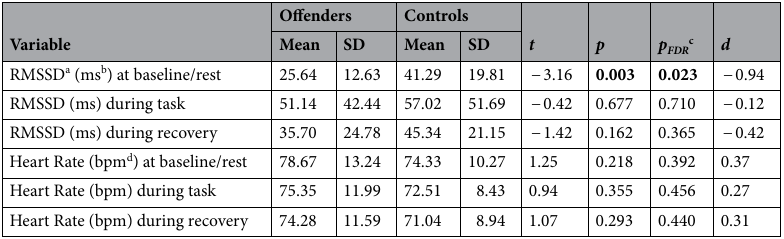
Table 1. Mean and standard deviation (SD) of the RMSSD in the offender and control groups. a RMSSD = Root mean square of the successive beat-to-beat differences. b ms = millisecond. c FDR = False discovery rate (q = 0.05) to correct for multiple comparisons. d bpm = Beats per